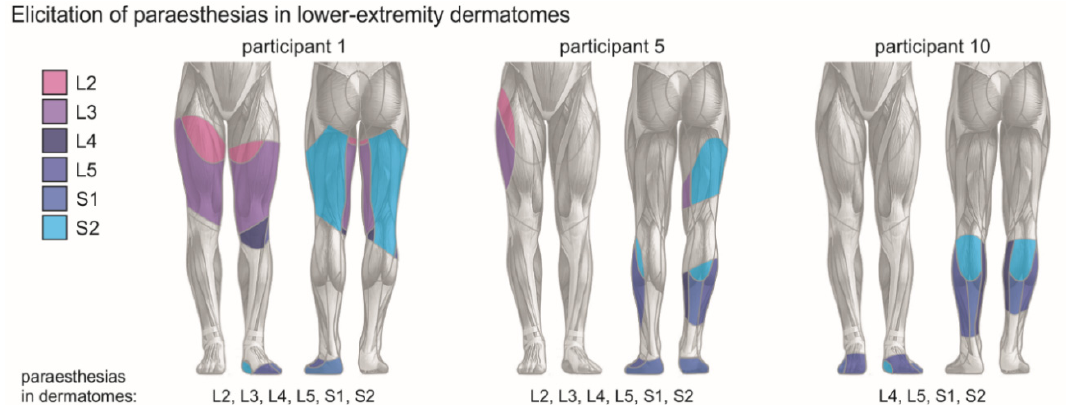
Figure A1. Verification of afferent fiber stimulation during transcutaneous spinal cord stimulation at 50 Hz by the elicitation of paraesthesias in L2 to S2 innervated lower-extremity dermatomes. Exemplary distribution of paraesthesias (shaded areas) as perceived by participants 1, 5, and 10 during the intervention. Table A1. Group results and statistical comparisons of tests conducted in assessments B1 and B2.